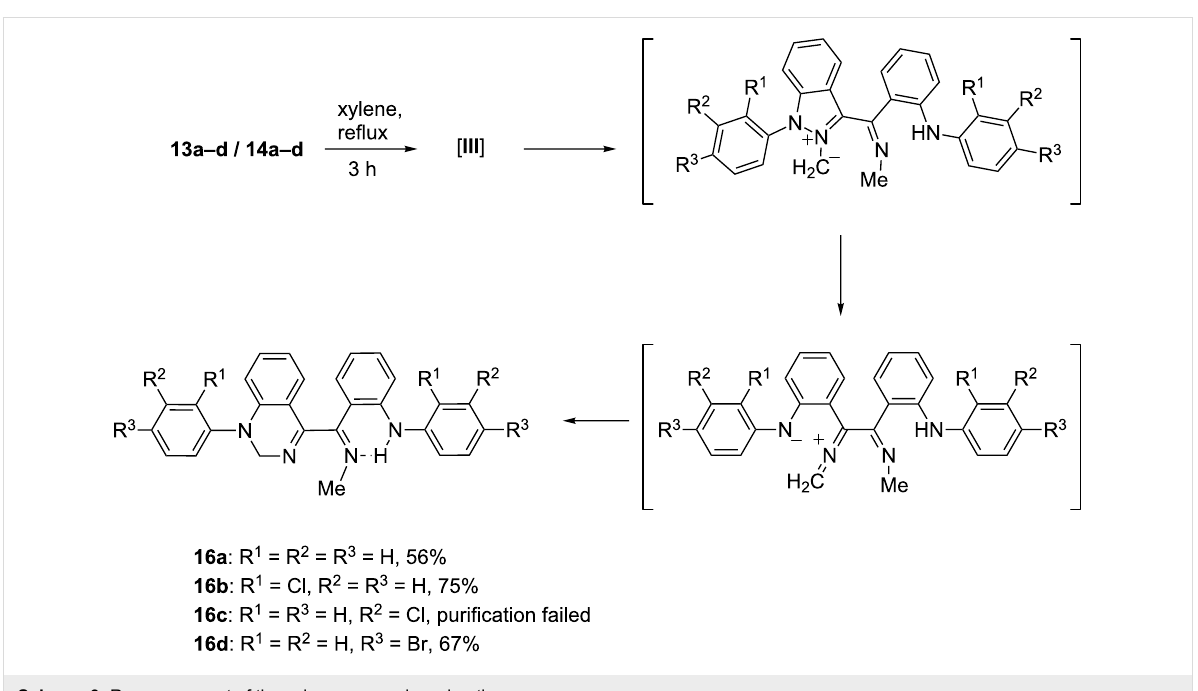
Another type of rearrangement occurred on heating the dimer- ized carbenes 13a–d / 14a–d in xylene, as the substituted quina- zolines 16a–d were isolated in reasonable yields (Scheme 6). Figure 4: Molecular structure of 16b , displacement parameters are drawn at 50% probability